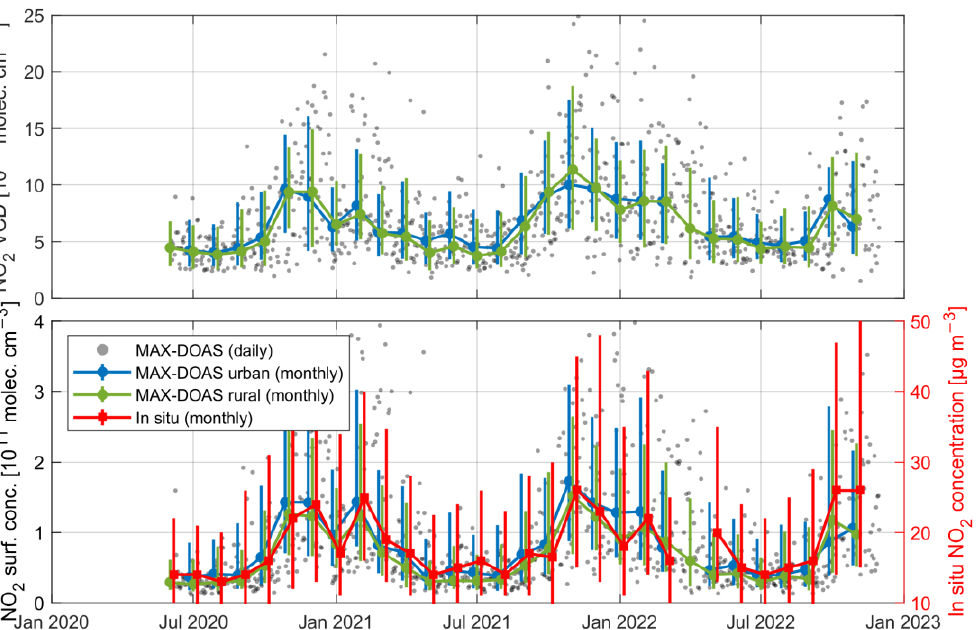
Figure 2. The time series of NO 2 vertical columns ( upper ) and surface concentrations ( bottom ) retrieved by the MAX-DOAS in Thessaloniki, Greece (gray dots represent the daily medians, while the blue and green lines with markers represent the monthly medians for the urban and rural azimuth viewing directions, respectively). The monthly median NO 2 surface concentrations measured by the in situ instrument are shown in red (right ordinate). The error bars of the monthly medians represent the variability as the interquartile range.